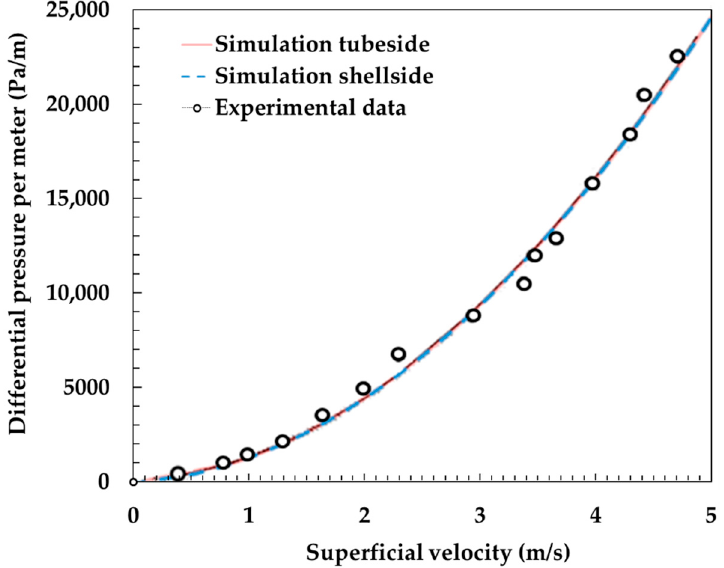
Figure 3. Comparison of differential pressure per unit length (Pa/m) with respect to superficial velocity (m/s) between the experiments [12] and the simulation results.